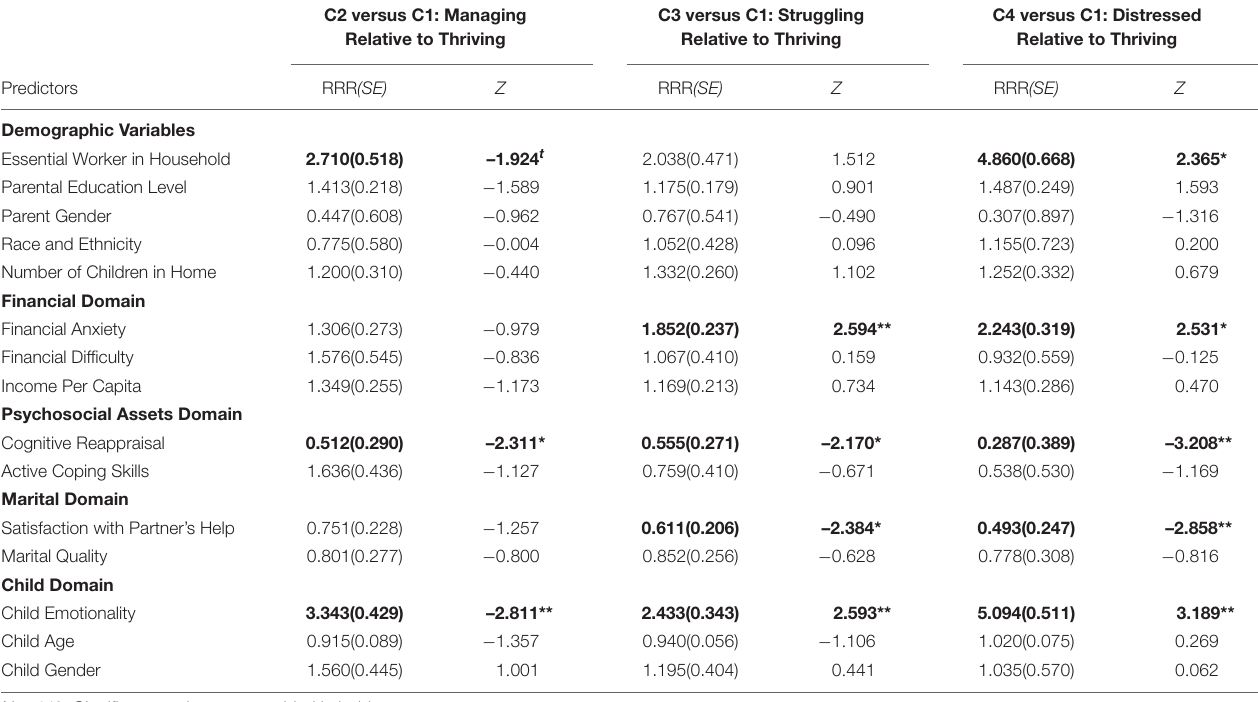
TABLE 3 | Multinomial logistic regression coefficients for financial, marital, psychosocial assets, and child predictors for latent profile membership.